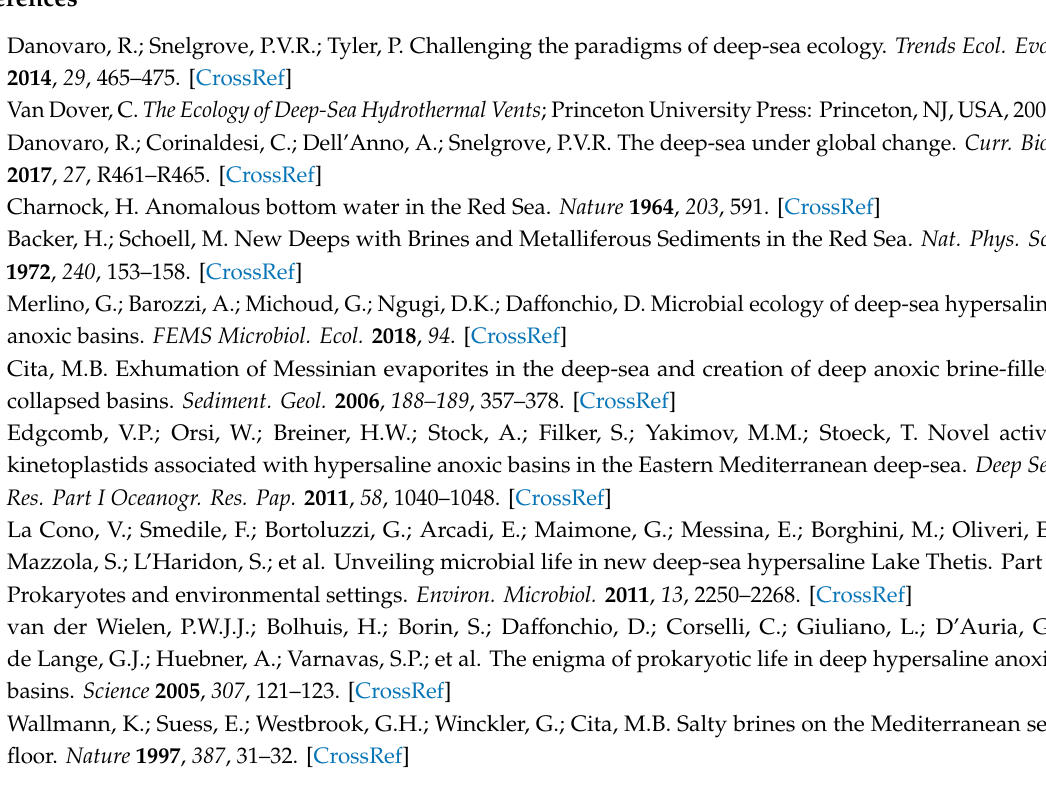
Table S1: Enzymes potentially produced by DHABs fungi: bioactivity and environmental